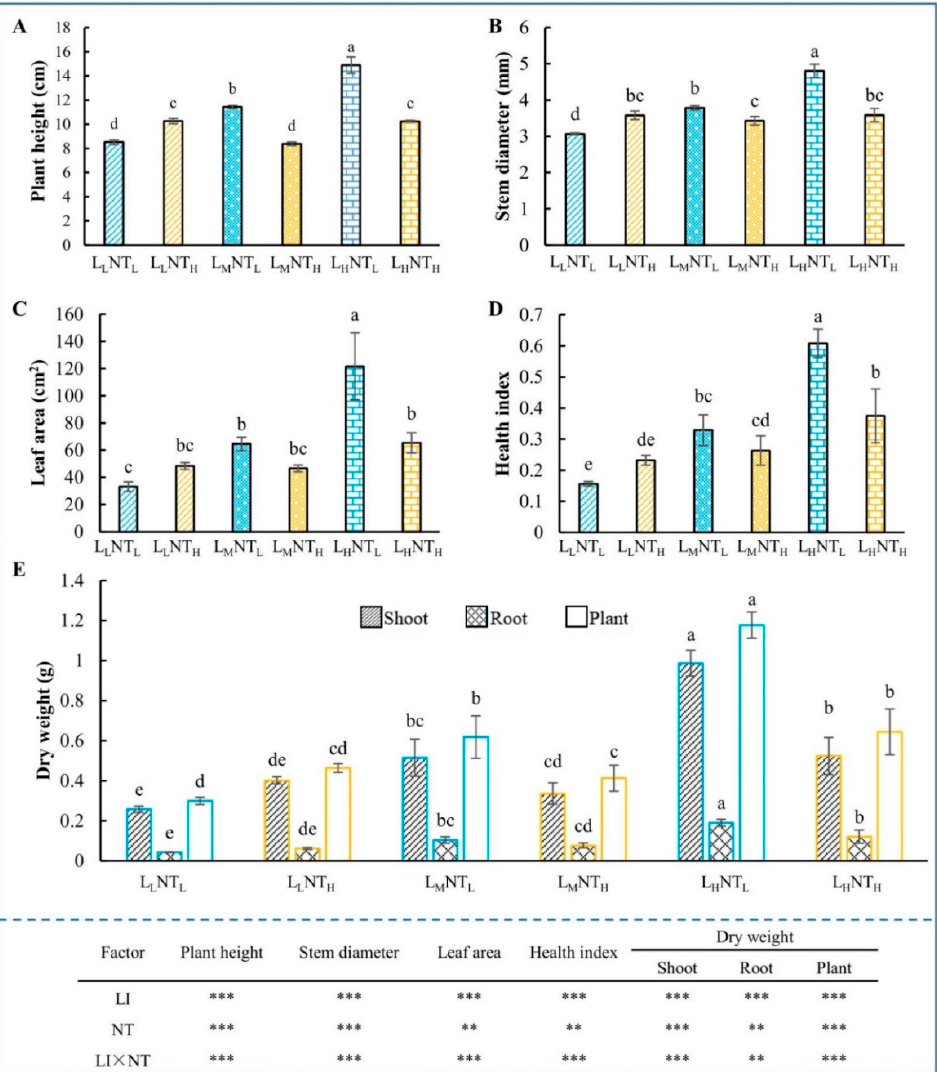
Figure 2. Effect of different light intensity (LI) and night temperature (NT) on plant height ( A ), stem diameter ( B ), leaf area ( C ), health index ( D ) and dry weight ( E ) of cherry tomato seedlings. Abbreviations of different treatments were as described in Figure 1. The symbol “**” and “***” indicate significant level at p < 0.01 and p < 0.001 by Duncan’s test, respectively. Different letters on bars for the same parameter indicate statistically significant differences ( p <